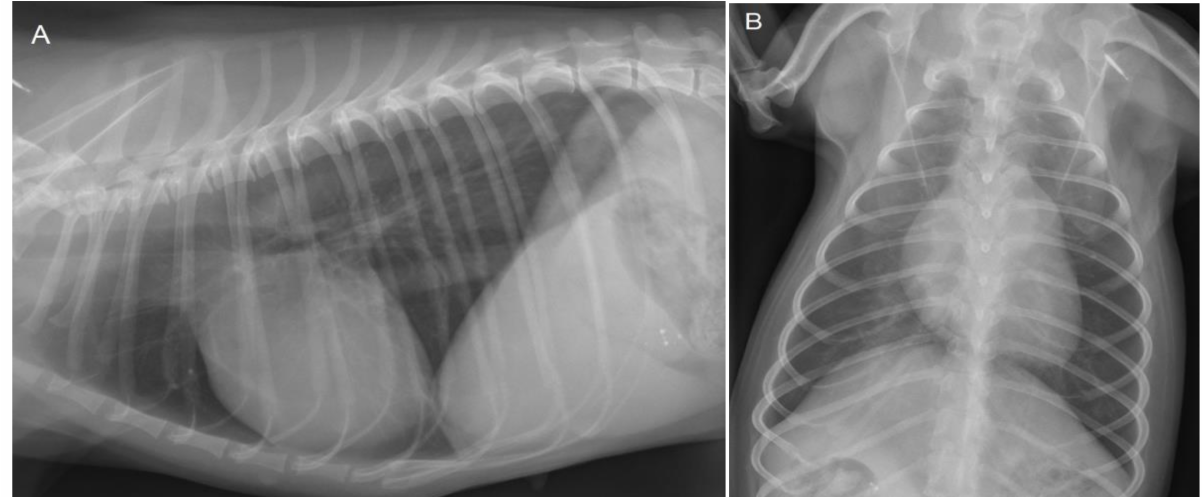
Figure 2. Lateral ( A ) and dorso-ventral ( B ) thoracic radiographs show no abnormalities at 3 years of age. The cardiac silhouette has a normal size and shape in both projections. The vertebral heart scale (VHS) is 10.5, which is within the breed-specific reference range for chihuahuas (8.9–11.0) [14]. There are no changes in the pulmonary parenchyma and pulmonary vasculature